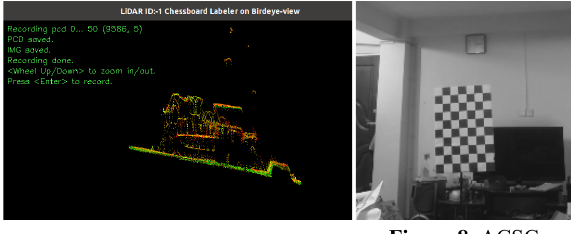
Figure 7. ACSC calibration interface